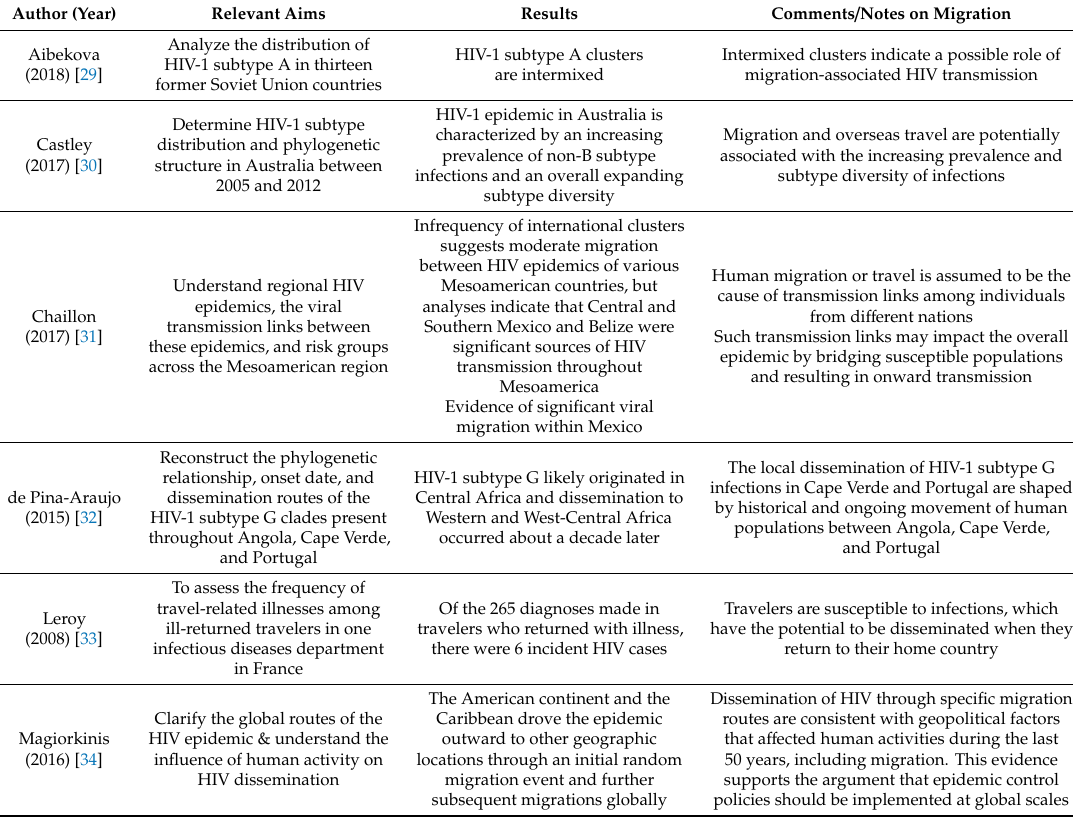
Table 1. Summary of articles reviewed regarding human mobility and